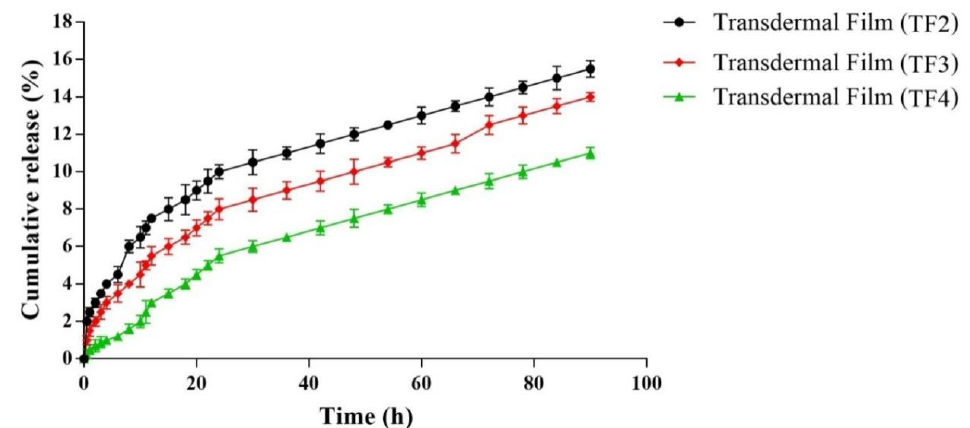
Figure 5. In vitro release of various batches of transdermal films.